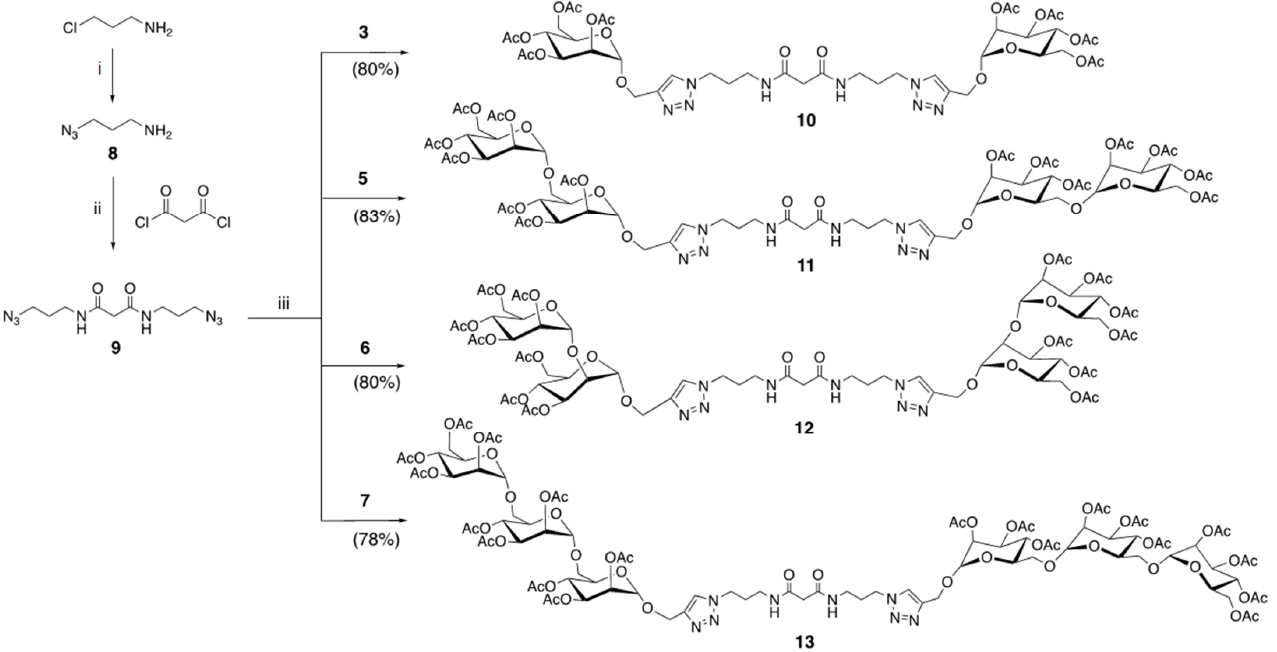
Scheme 2. Synthesis of sugar-modified malondiamide linkers. Experimental conditions: (i) 3-chloro propylamine, NaN 3 , H 2 O, 80 ◦ C, 6 h (91%); (ii) malonyl chloride, aqueous NaOH, CH 3 Cl, 0 ◦